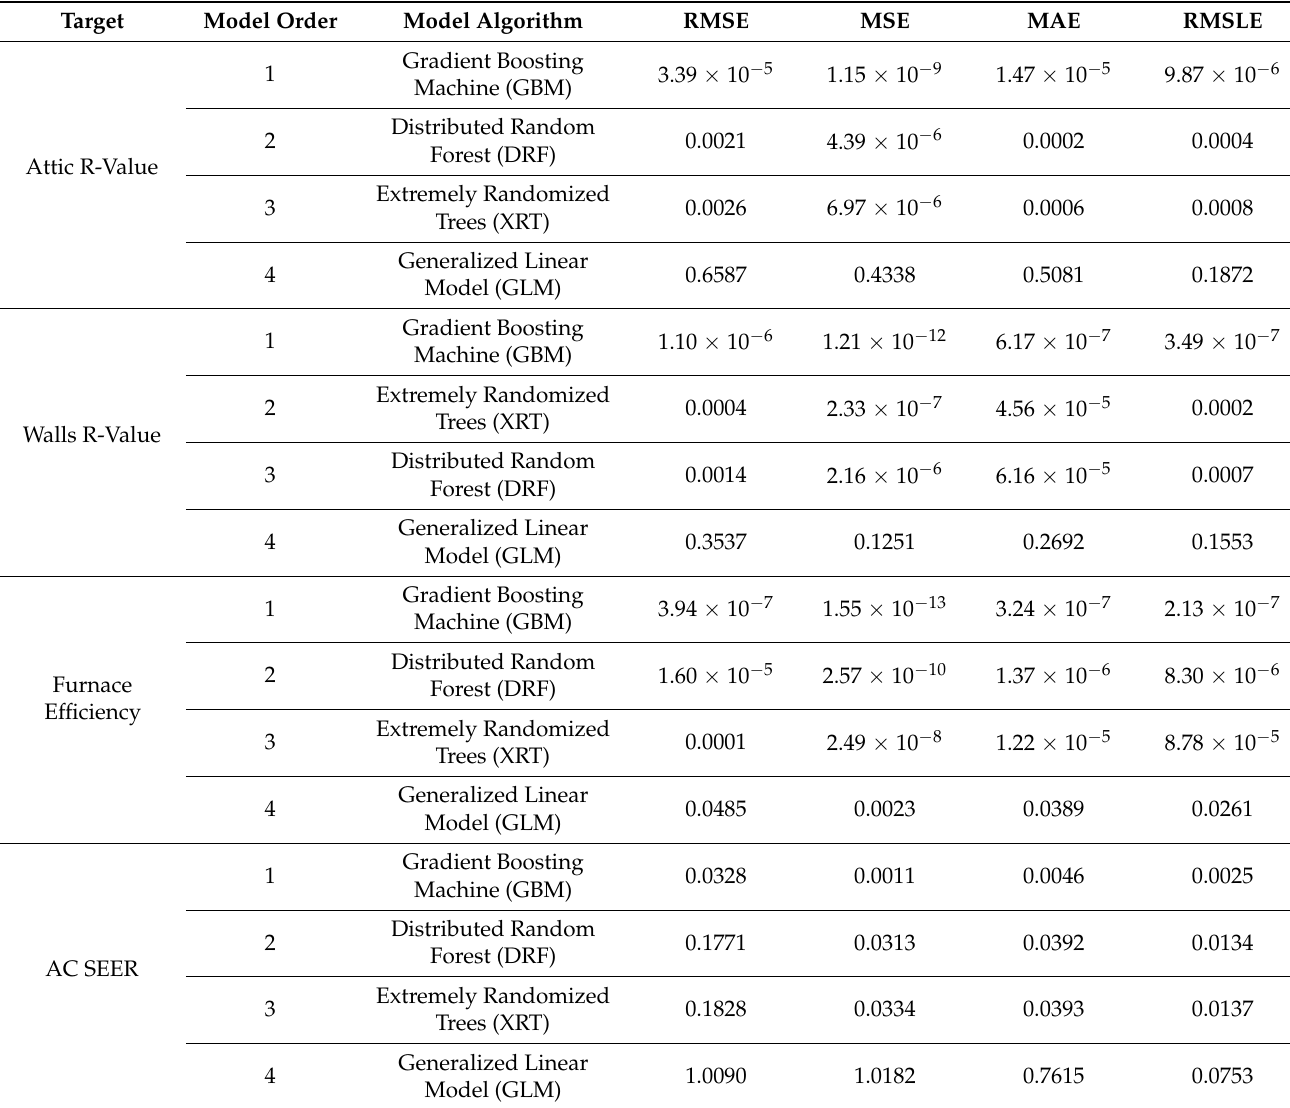
Table 5. Validation metrics for model development using the complete feature dataset with different machine learning algorithms.